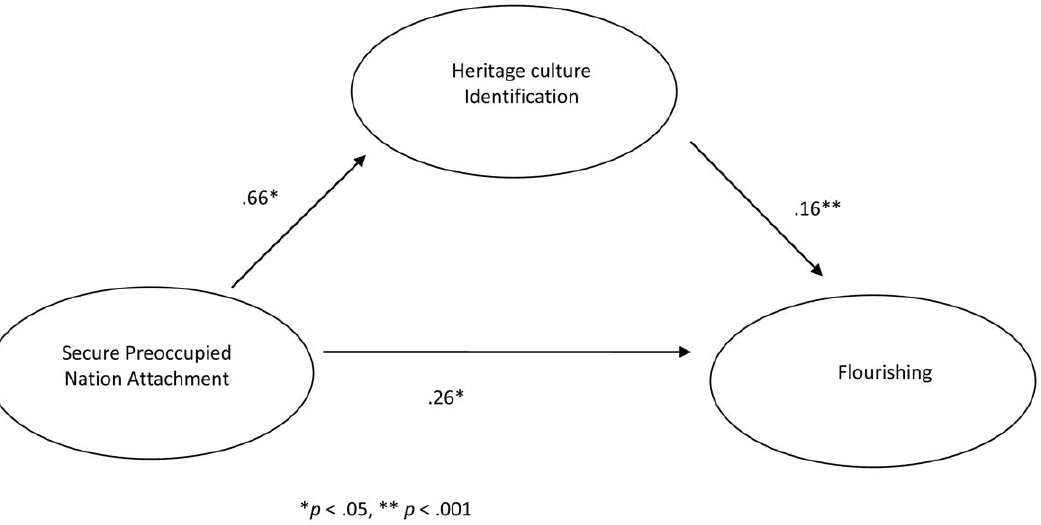
Figure 6. Mediating role of heritage culture identification on the association between secure preoccupied nation attachment and flourishing in Study